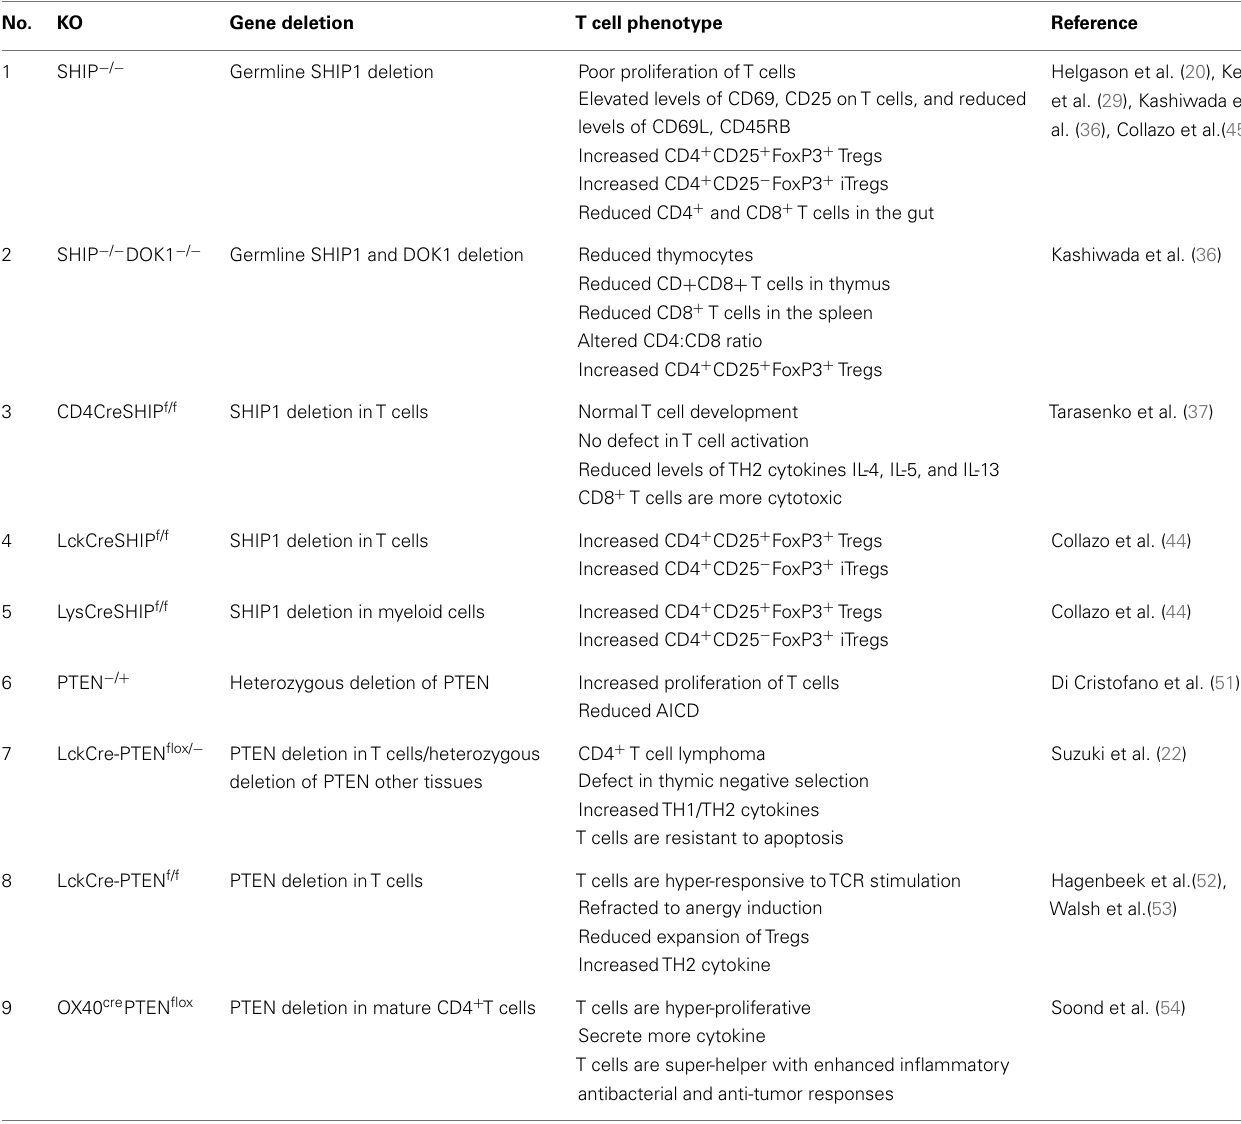
Table 1 |T cell phenotypes of inositol poly-phosphatase mutant